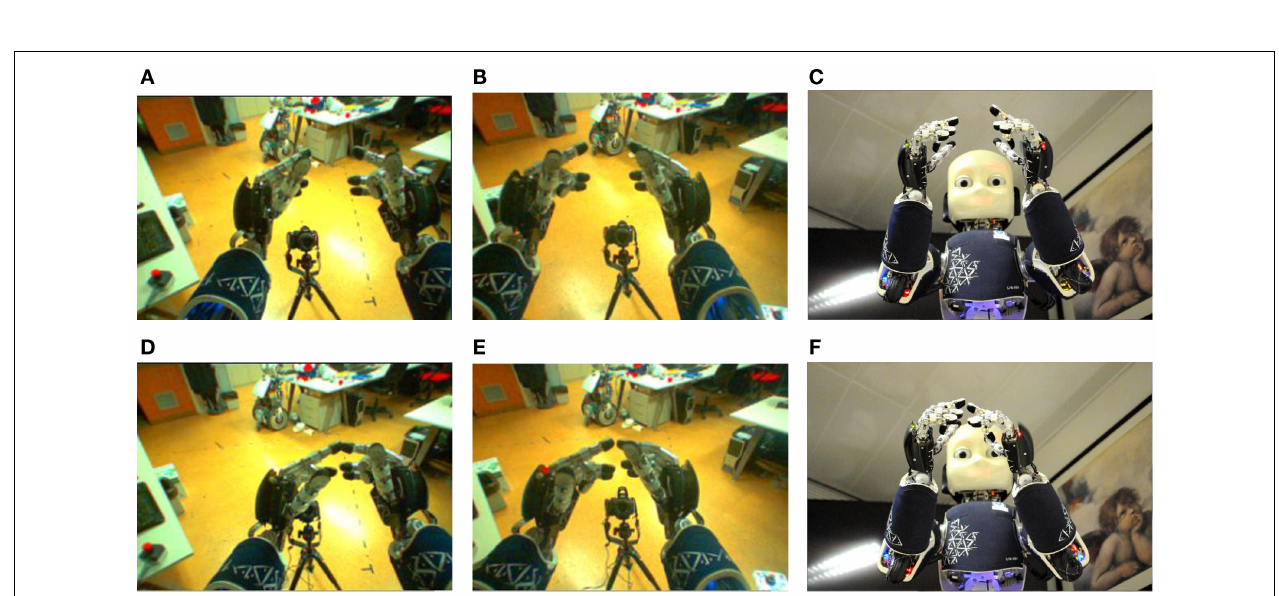
FIGURE 13 | Body schema online adaptation performed in the real robot . Images seen by the robot eye cameras Left (A,D) and Right (B,E) Cameras and by external camera (C,F) placed in front of the robot. First row (A–C) : the left arm is controlled toward a target end-effector pose and the right arm is controlled toward the same end-effector pose with a shift of 12cm, with open-loop control. However, the resulting end-effector poses are not the desired one, due to inaccuracies in the body schema. Adaptation parameters are estimated during the motion of both arms, and used to update the body schema. Second row (D–F) : the pose of both end-effectors is corrected using the updated body schema and a closed-loop control strategy that exploits the improved pose estimation.